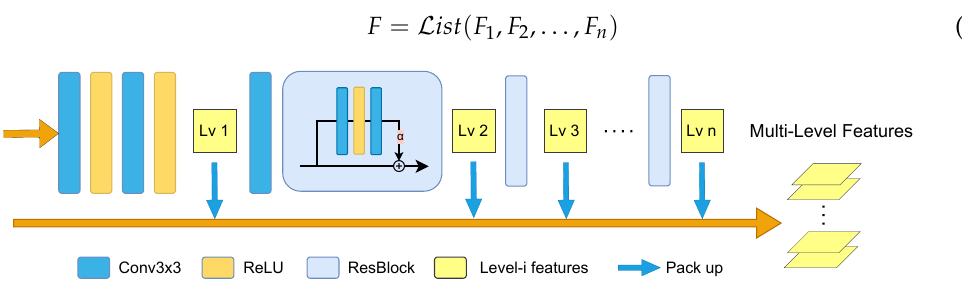
Figure 2. The structure of the multi-level features extractor. Feature fusion: The process of feature fusion is illustrated in Figure